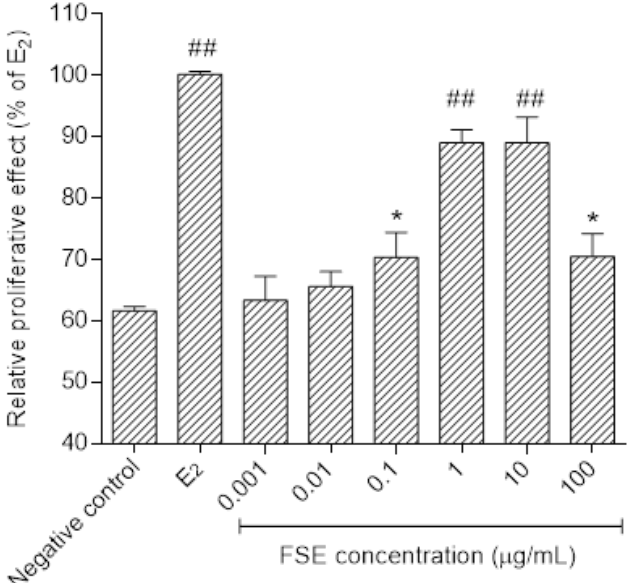
Figure 2. Estrogen - like activities determined in MCF - 7 cells of FSE, * p < 0 . 05, # p < 0 . 01, ## p < 0 . 001 compared to negative control (C) . Each value represents the mean ± SD, n = 3 .